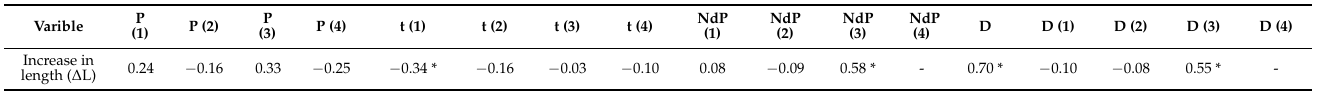
Table 2. Correlations between plant growth and selected meteorological parameters and the length of development